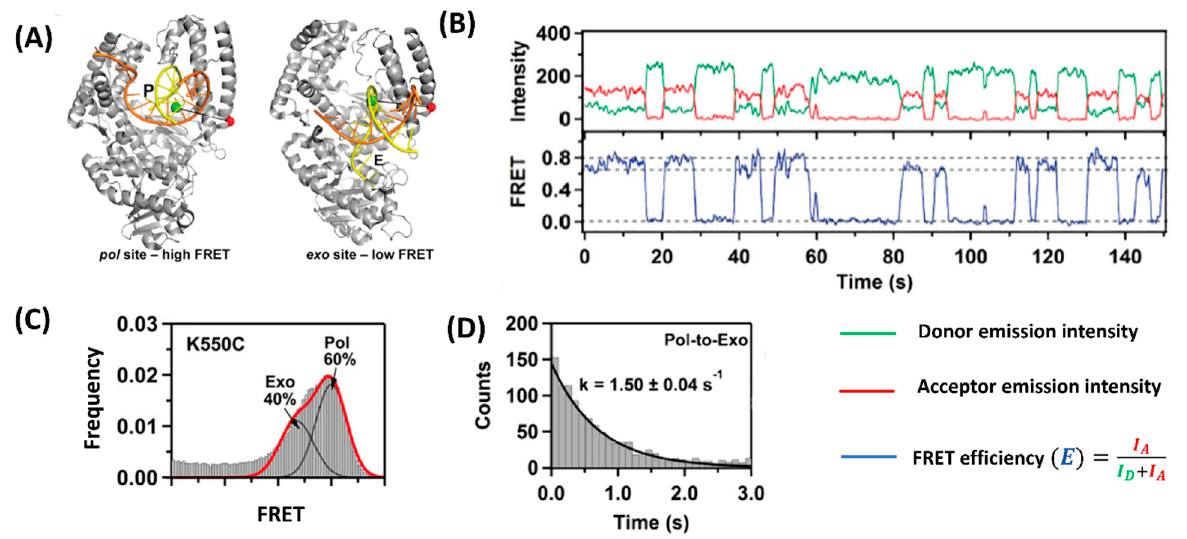
Figure 4. ( A ) Two distinct conformational states detected upon the binding of the Klenow fragment of Pol I. ( B ) The representative trace denoting the changes in the intensities of the donor (green) and the acceptor (red). The FRET efficiency (blue) was extracted. ( C ) The FRET efficiency histogram extracted from the intensities of the donor and the acceptor. Two conformational states were detected and quantified. ( D ) The histogram of the time taken for Pol II to transition from Pol to Exo site. It was fitted (black line) with a single exponential function to obtain the rate constant (k). Figure is adapted from [44] (Berezhna, S.Y.; Gill, J.P.; Lamichhane, R.; Millar, D.P. Single-molecule Förster